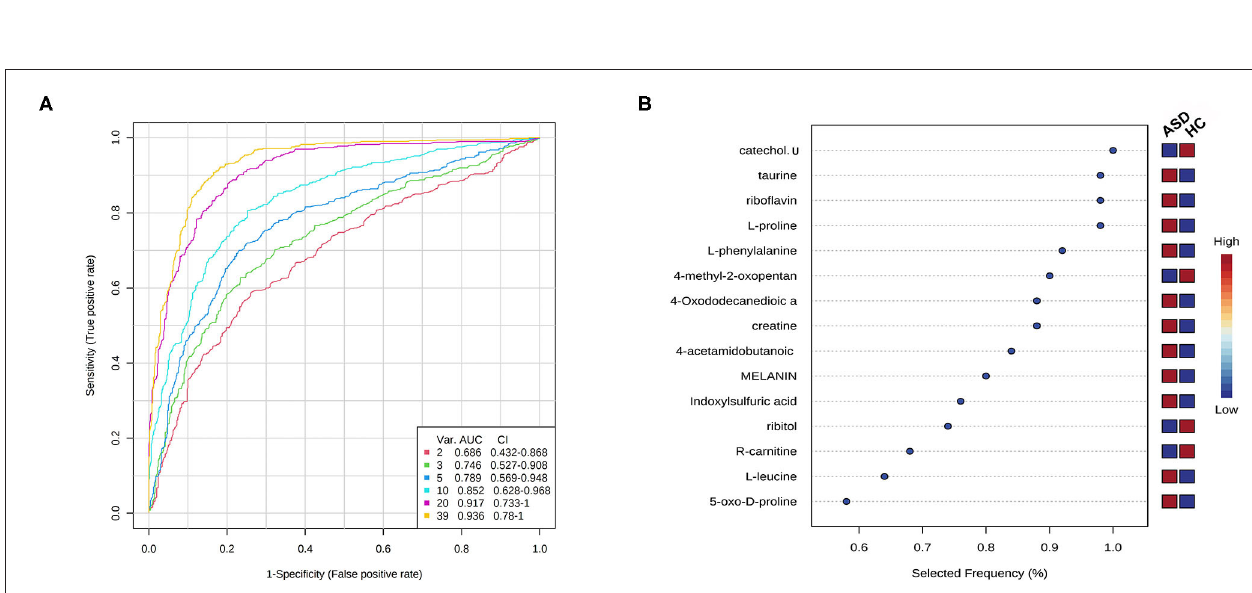
Frontiers in Psychiatry |